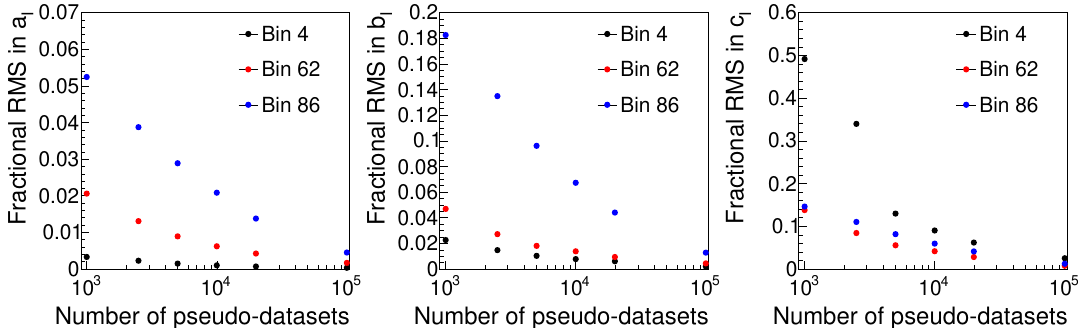
Figure 6 . RMS of the SL coe(cid:14)cients relative to the mean coe(cid:14)cient value determined from 100,000 pseudo-datasets for a (left), b (middle), and c (right). The distributions are shown for I = 4 I I I (black points), I = 62 (red points) and I = 86 (blue